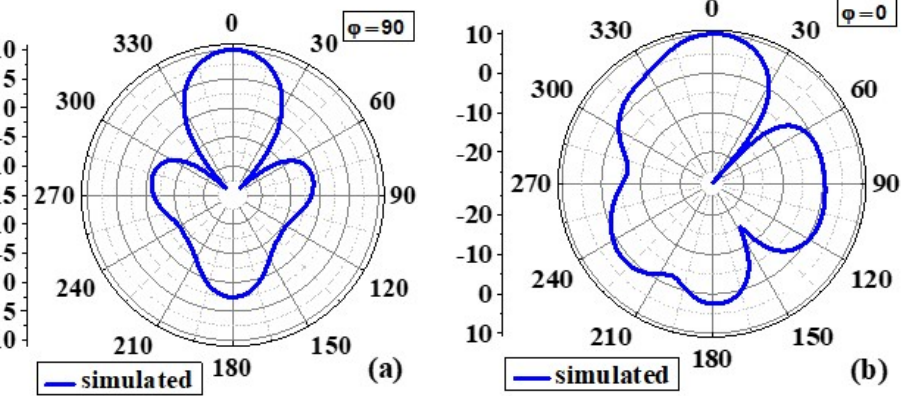
Figure 9. Simulated 2D radiation pattern of the proposed antenna with AMC at 8.6GHz: ( a ) φ = 90 and ( b ) φ = 0.